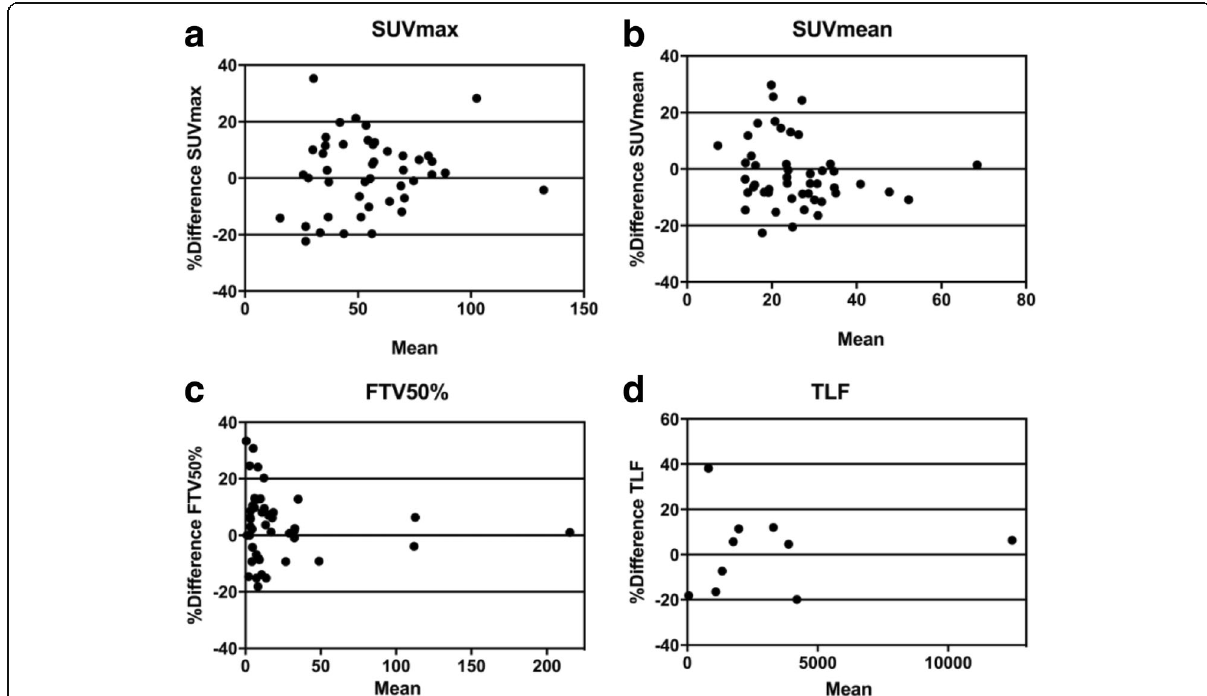
Fig. 2 Bland-Altman difference plots in relative values for 18F-fluoride PET repeatability: a mean SUVmax, b mean SUVmean, c mean FTV 50% and d mean TLF